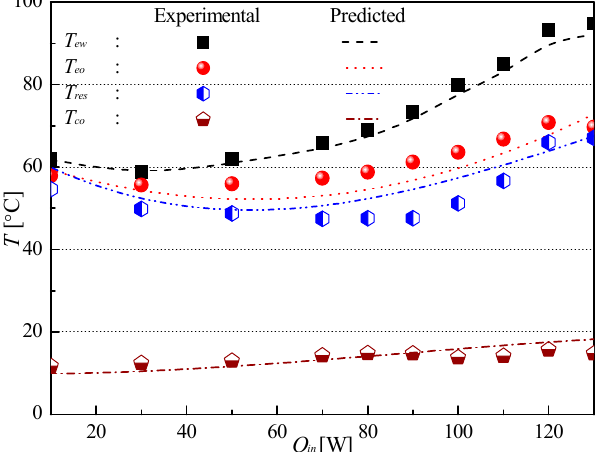
Figure 9. Trends concerning temperature change with step increase in evaporator thermal load at adverse 10° orientation.